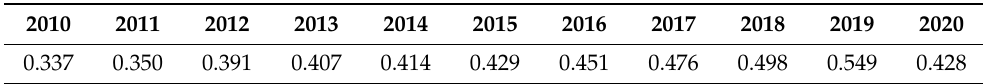
Figure 14. LISA aggregation diagram of the 11 counties’ CGLUE in 2020. Table 3. Global Moran’s I statistic of CGLUE in study